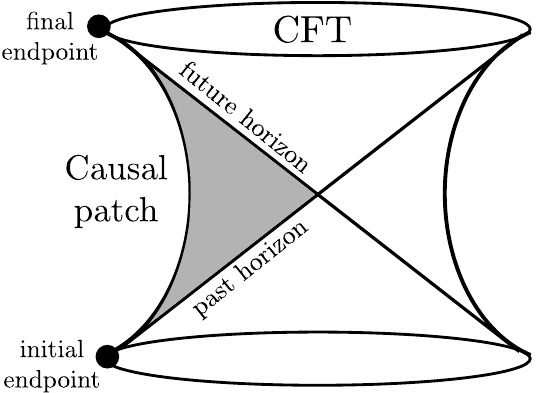
Figure 1 . The basic problem of dS/CFT. De Sitter space is represented as a hyperboloid in 4+1d embedding space. The CFT is defined on the Euclidean conformal boundary. Lorentzian physics, including commutators of quantum fields, only takes place in the bulk. Moreover, the conformal boundary is unobservable. An observable bulk patch (shaded) intersects the boundary at two points — the initial and final endpoints of the observer’s